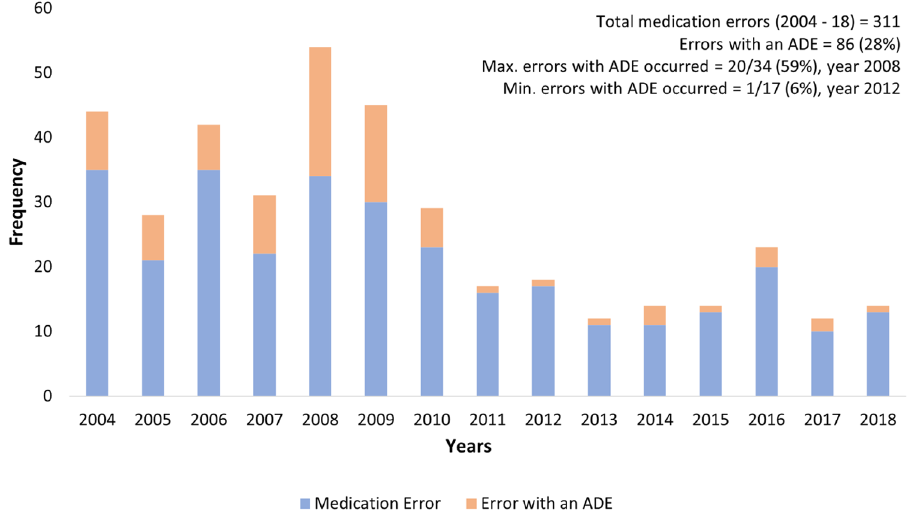
Figure 1. Comparison of medication errors with Adverse Drug Event